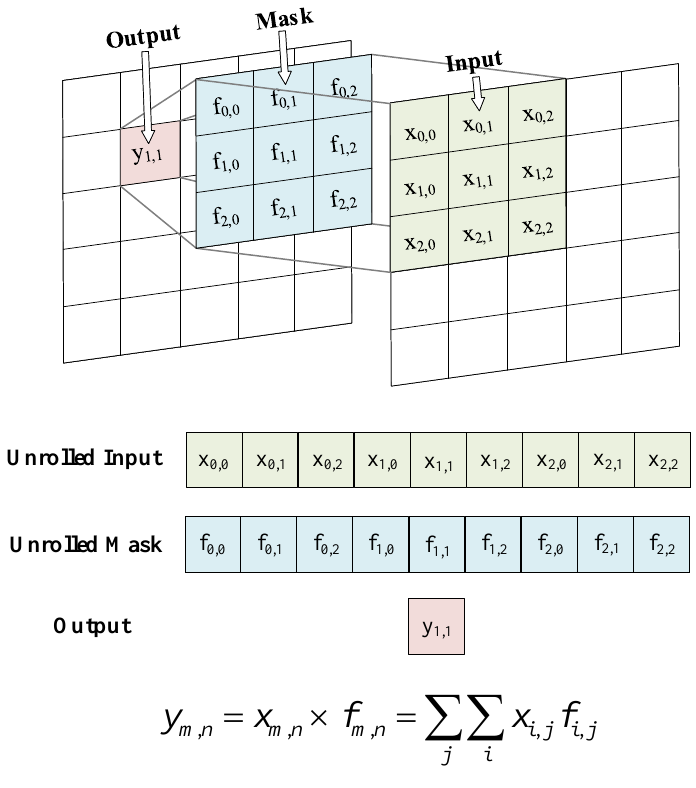
Figure 6. 2D matrix